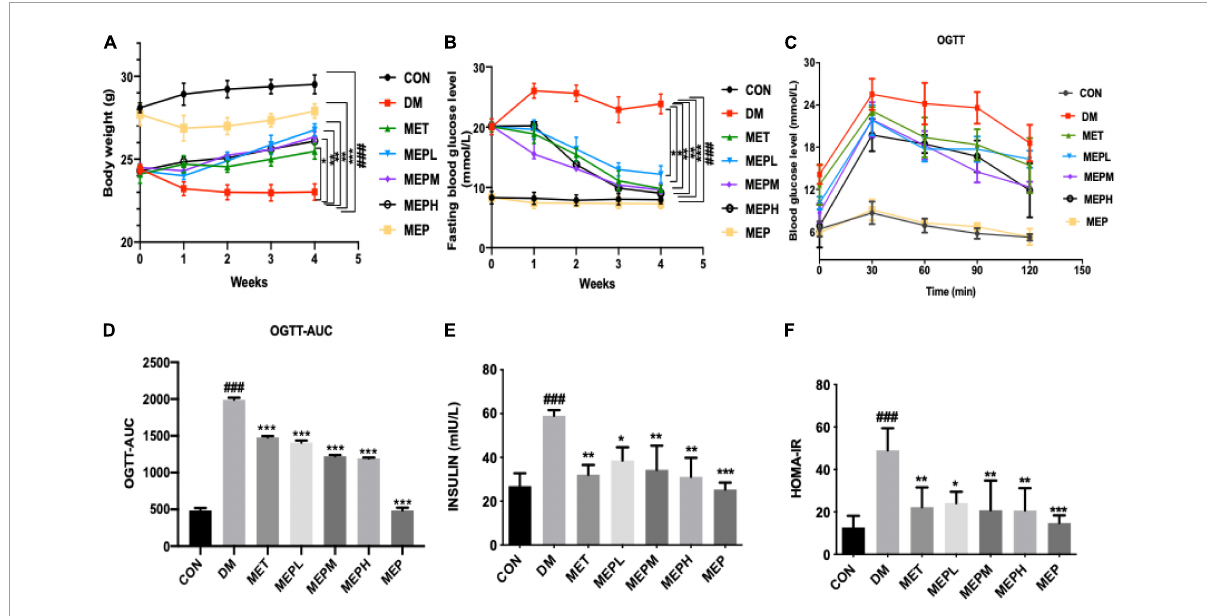
FIGURE3 (A) The bodyweight of mice was measured daily during MEP treatment (B) FBG level, (C) OGTT, (D) The trapezoidal rule was used to calculate the AUC of OGTT, (E) serum insulin level, and (F) HOMA-IR was measured after T2DM treatment with MEP in different groups. # indicates a significant difference compared with the control group. ### p < 0.001 vs. control. *indicates significant difference compared with DM group. * p < 0.05, ** p < 0.01 and *** p < 0.001 vs. DM. Data were presented as mean ± standard error of mean